Question: What type of chart is this?
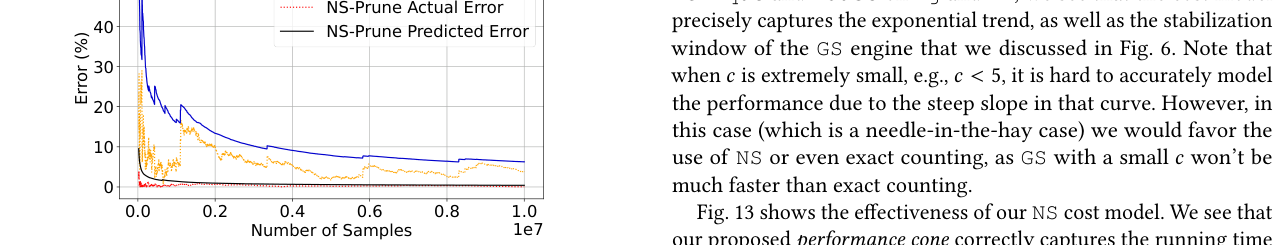
Answer: line